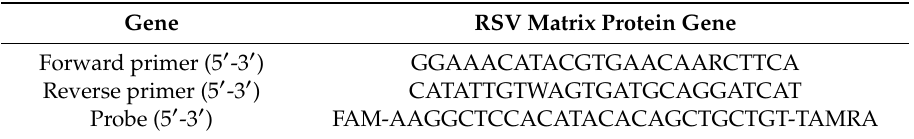
Table 1. Primer and probe sequence for Quantitative Reverse Transcription Polymerase Chain Reaction (RT-PCR). Gene RSV Matrix Protein Gene Forward primer (5 (cid:48) -3 (cid:48)